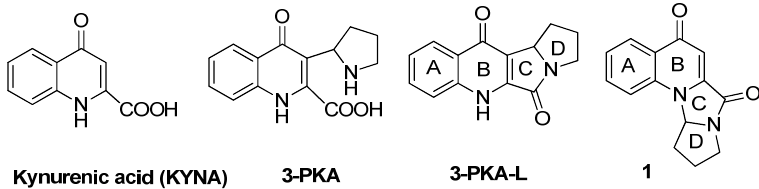
Figure 1. Structures of KYNA, its metabolites 3-PKA and 3-PKA-L and the analogue 1.